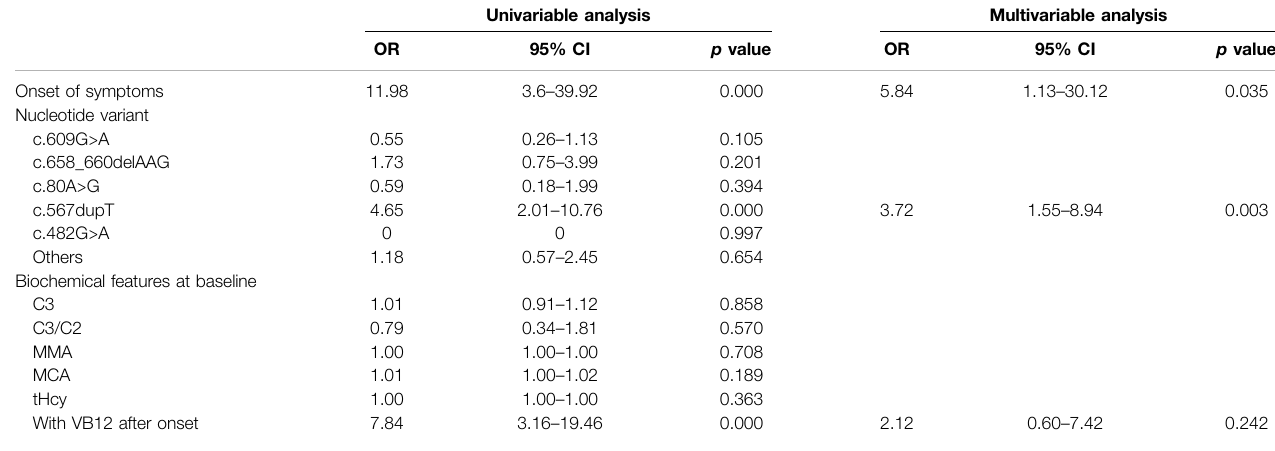
TABLE 5 | Univariate and multivariate analysis of predictors for ocular